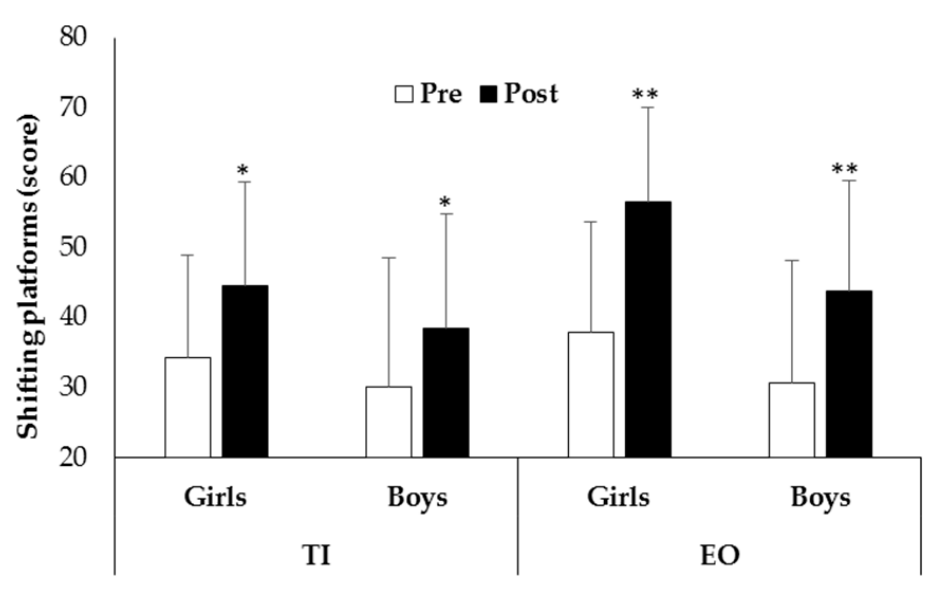
Figure 4. Shifting platforms test of girls and boys before (Pre) and after (Post) intervention in experi- mental outdoor intervention (EO) and traditional indoor intervention (TI) (* p < 0.01, ** p < 0.001).